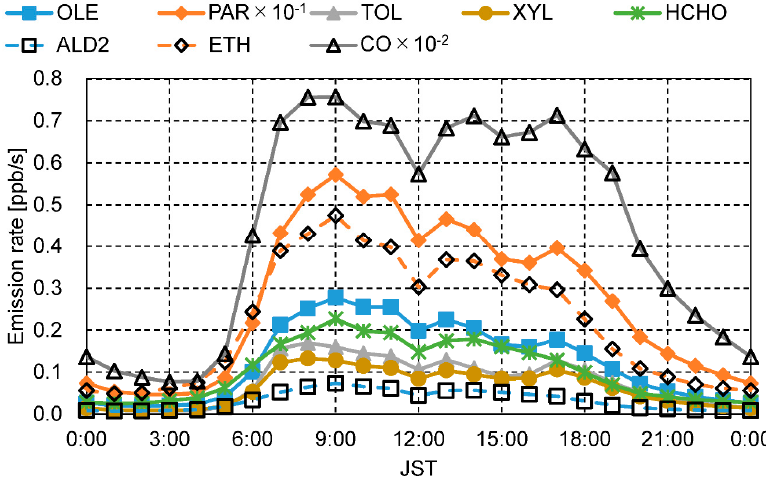
Figure A2. Emission rate of pollutants except NO x from 18:00 August 22 to 24:00 23 August 2010.